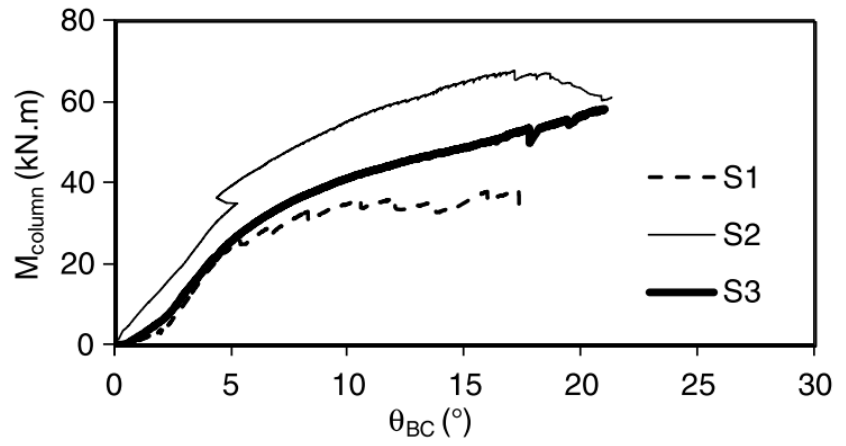
relationships of monotonic loading tests are shown in (Figure 8).